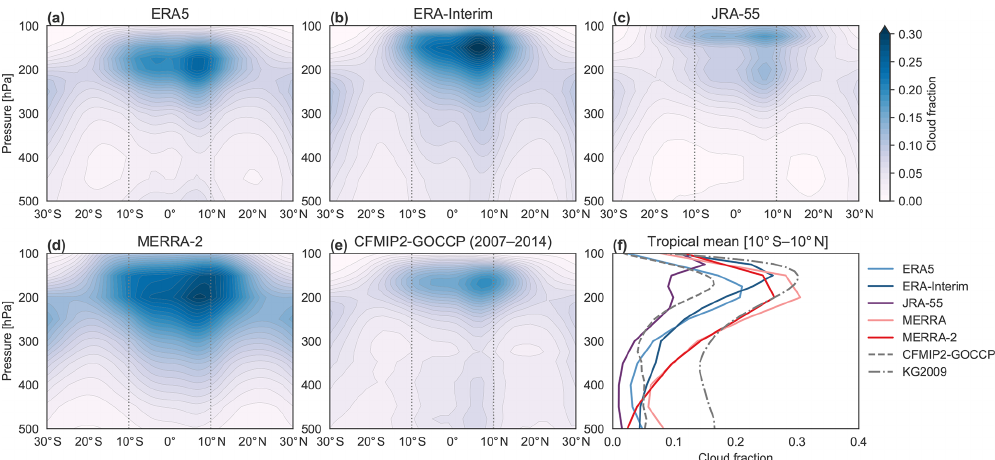
Figure 3. Time-mean zonal-mean distributions of cloud fraction based on the (a) ERA5, (b) ERA-Interim, (c) JRA-55, and (d) MERRA- 2 reanalyses (1980–2014), along with (e) an observationally based distribution from the GOCCP CALIPSO-based product produced for CFMIP2 (Chepfer et al., 2010), which covers 2007–2014. Inner-tropical-mean (10 ◦ S–10 ◦ N) profiles of cloud fraction based on these five estimates are shown in (f) , along with profiles from MERRA and the combined CloudSat–CALIPSO product derived by Kay and Gettelman (2009). The latter is averaged over 2007–2011. Vertical lines in (a) through (e) mark the bounds of the averaging domain. CFSR does not provide vertical profiles of cloud